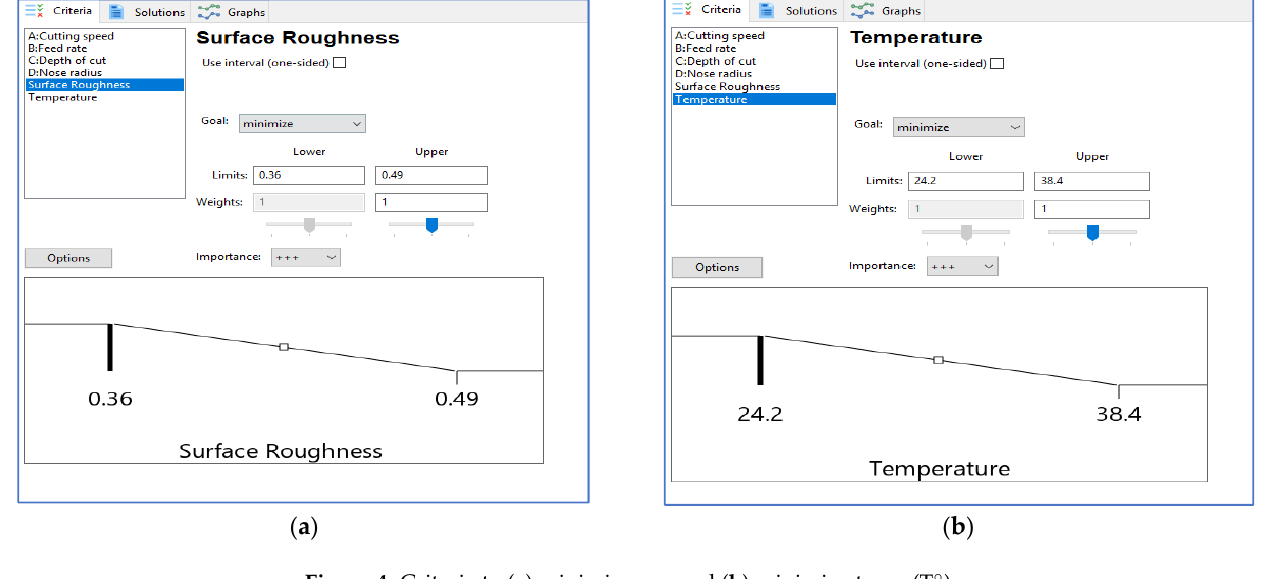
Figure 4. Criteria to ( a ) minimize µm and ( b ) minimize temp (T°).